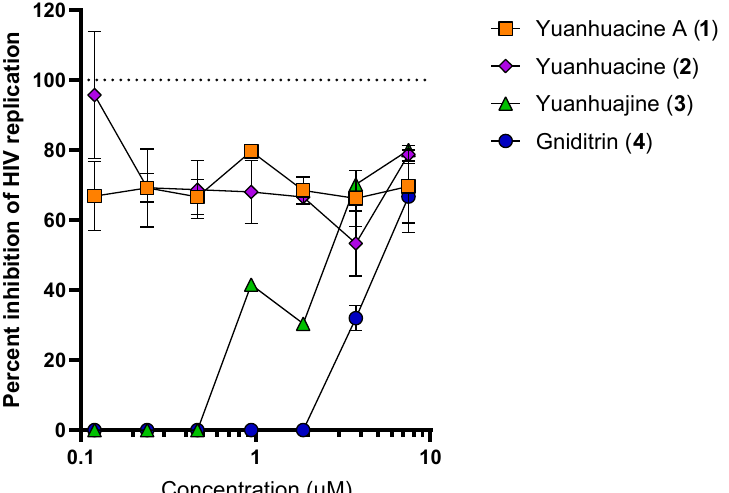
Figure 4. Anti-HIV replication activity of isolated compounds as measured using the deCIPhR in vitro assay.